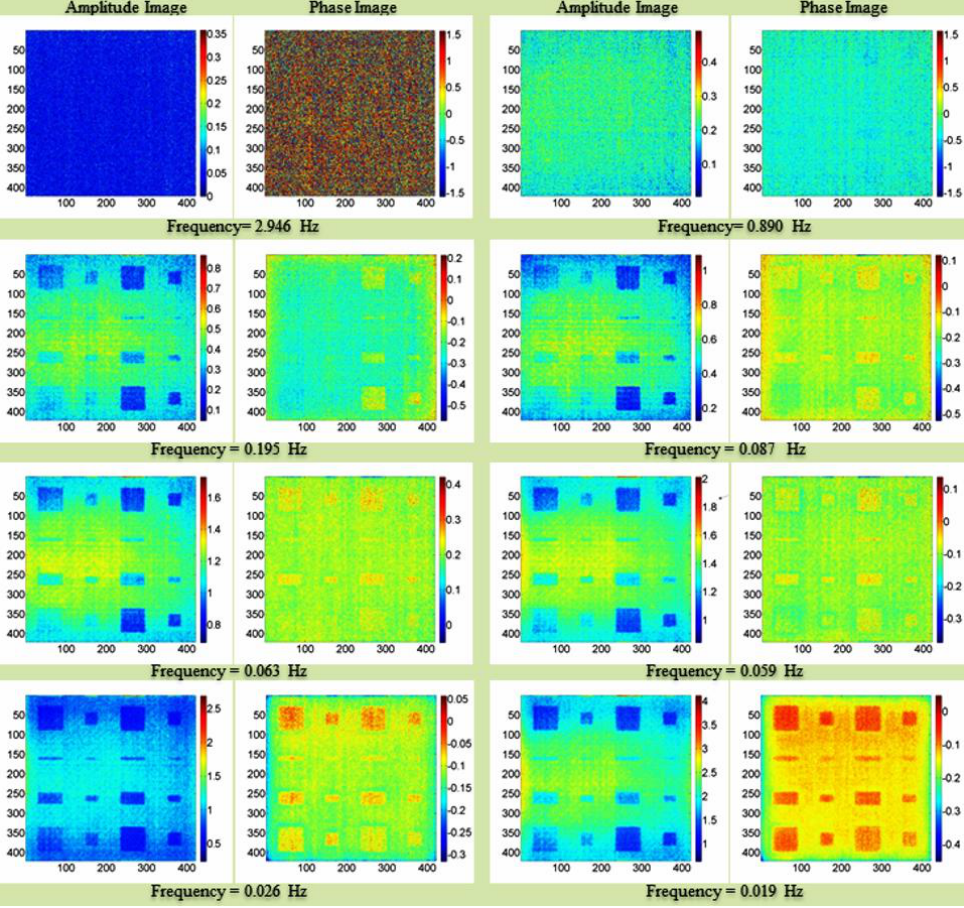
Figure 8. Lock-in thermography amplitude and phase images on a GFRP composite plate with artificial defects, with permission from Error! Reference source not found. .